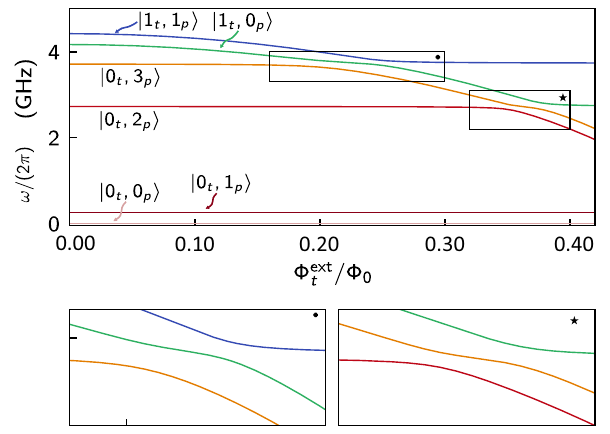
FIG. 5. The effect of a cosine error in the PPQ. The low- energy spectrum of the hybrid qubit setup for n g , p = 0 and ) = 2 π( 12, 2.7, 0.2, 0.18, 0.025 ) GHz ( E J , t , E J , p , E C , t , E C , p , E C , c as a function of the external flux (cid:6) ext of the tunable trans- mon in the presence of an error term H x = ε x cos (φ p ) with ε x = 0.05 E J , p . The error term introduces additional anti- crossings between states of opposite Cooper-pair